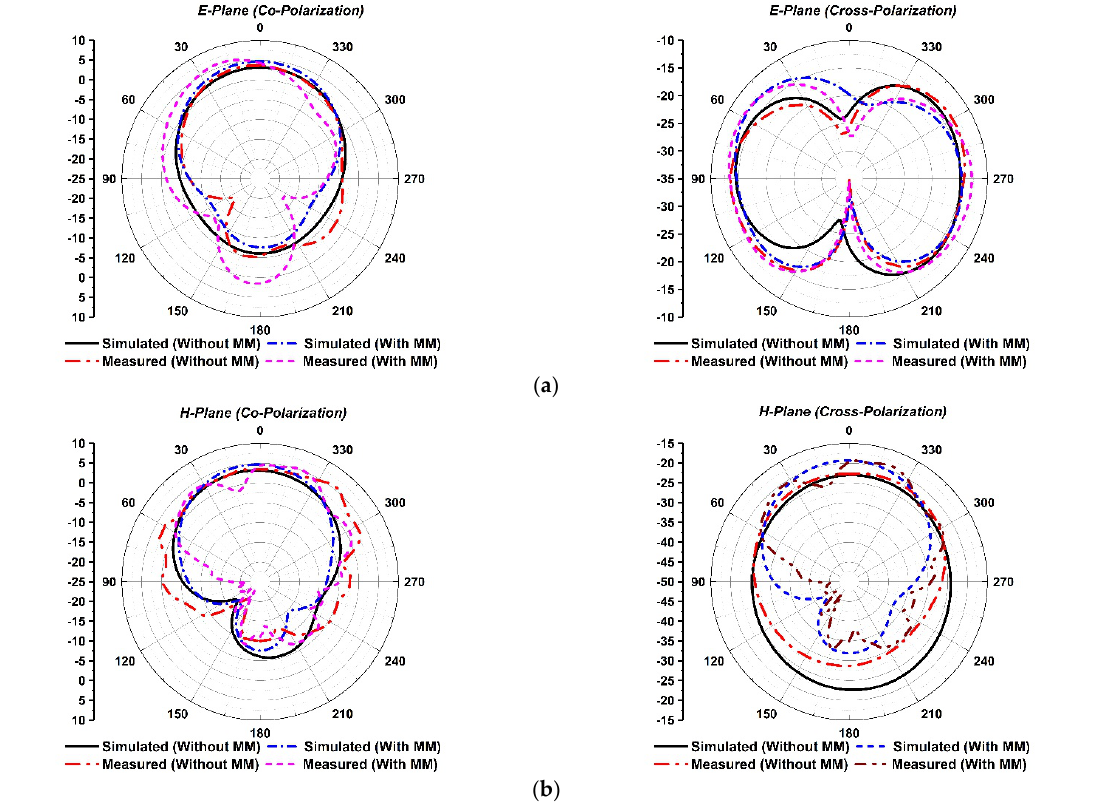
Figure 23. Radiation patterns with and without MM reflector at 3.5 GHz: ( a ) E-plane; ( b ) H-plane. 10. Performance Comparison with the Existing Contributions The proposed polarization-insensitive symmetric DNG MM performance is compared to recently published literary works in the relevant area, as shown in Table 3. The comparisons were conducted based on structural type, negative characteristics, operational frequency ranges, EMR, polarization insensitivity, and antenna gain enhancement. Table 3. Contrast between the proposed MM and existing relevant work.